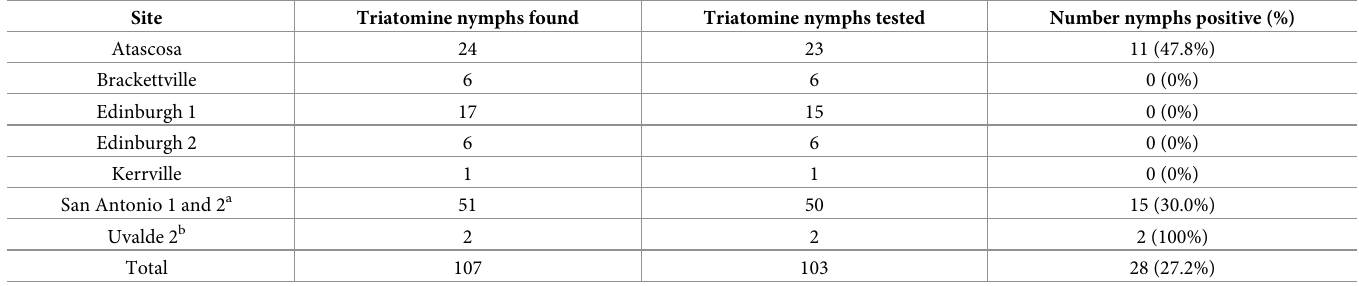
From October to December 2017, a total of 110 triatomines (107 nymphs and 3 adults) were collected at 8 sites across Texas. A subset was tested for T . cruzi DNA from either fecal spots or hind gut dissections.